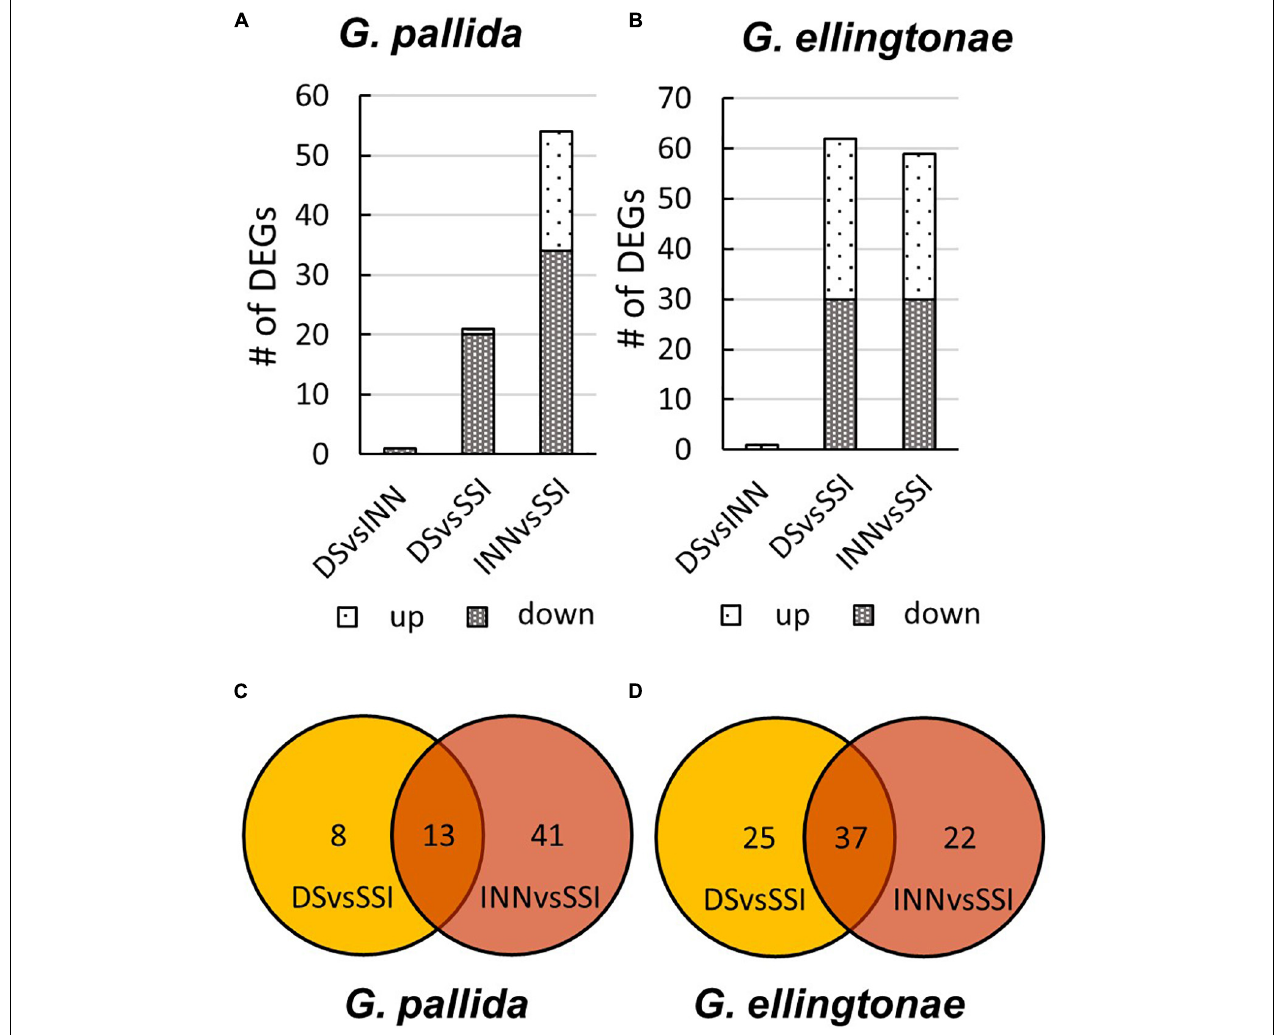
FIGURE 6 | The number of differentially expressed genes (DEGs) for (A) Globodera pallida or (B) Globodera ellingtonae based on a comparison between different hatching conditions: DS - susceptible potato control cv. Desirée, INN - resistant potato cv. Innovator, and SSI - an immune plant S. sisymbriifolium . The overlap of DEGs identified between DS vs SSI and INN vs SSI comparisons for (C) G. pallida and (D) G. ellingtonae